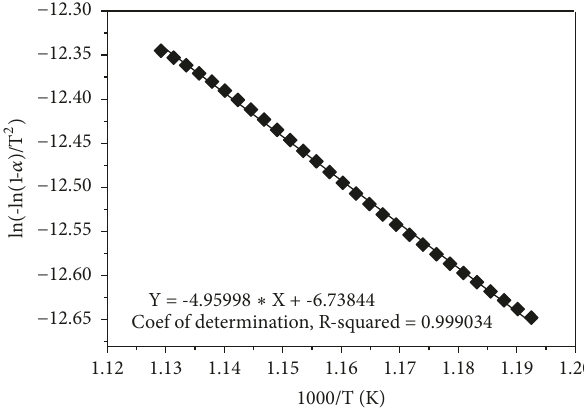
Figure 7: Plots of ln(-ln(1- 𝛼 )/ T 2 ) versus 1000/ T of the coal sample.